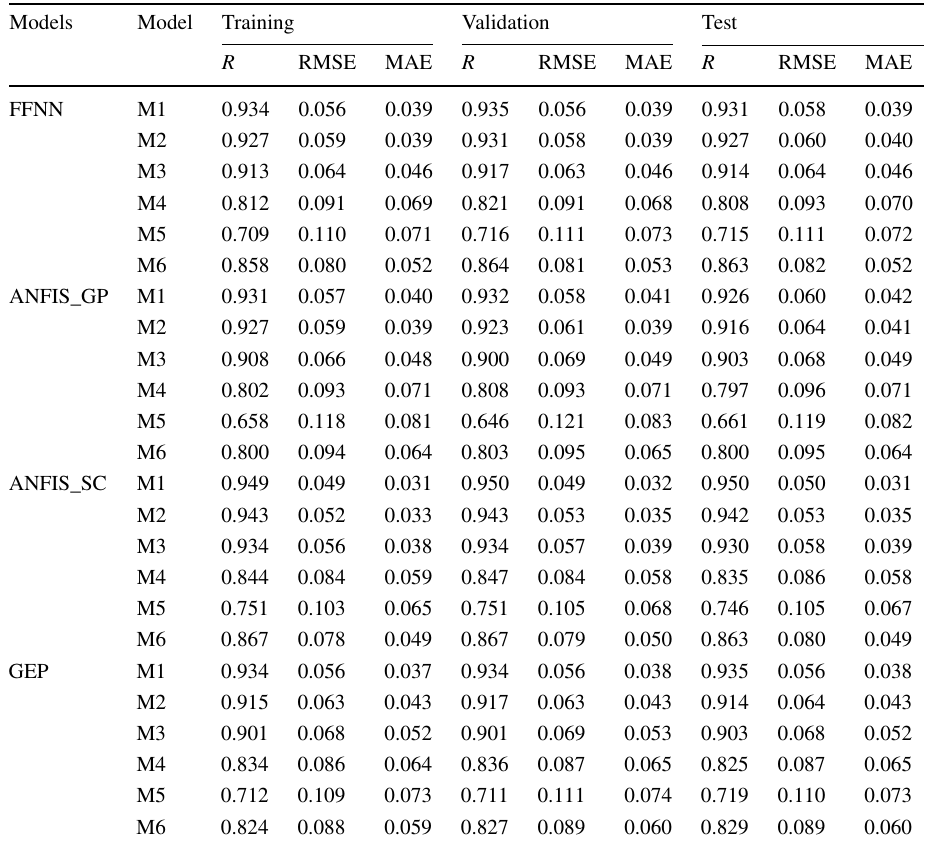
Table 9 Performances of the FFNN, ANFIS_SC, ANFIS_GP and GEP models in different phases for USGS 14211720 station